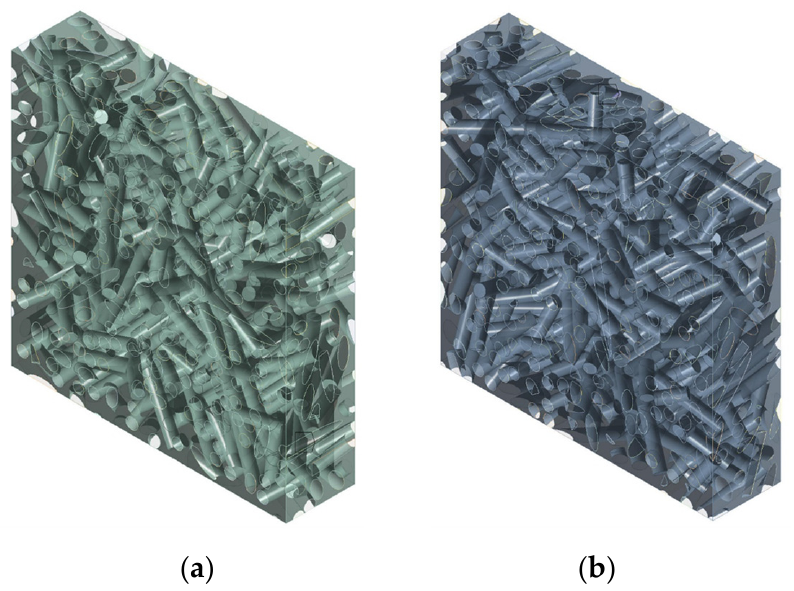
Figure 4. 3D transparent view of two different RVEs of an epoxy short sisal fiber biocomposite with V f = 0.35, as used for the validation of the numerical model: ( a ) first generation run, ( b ) second generation run.